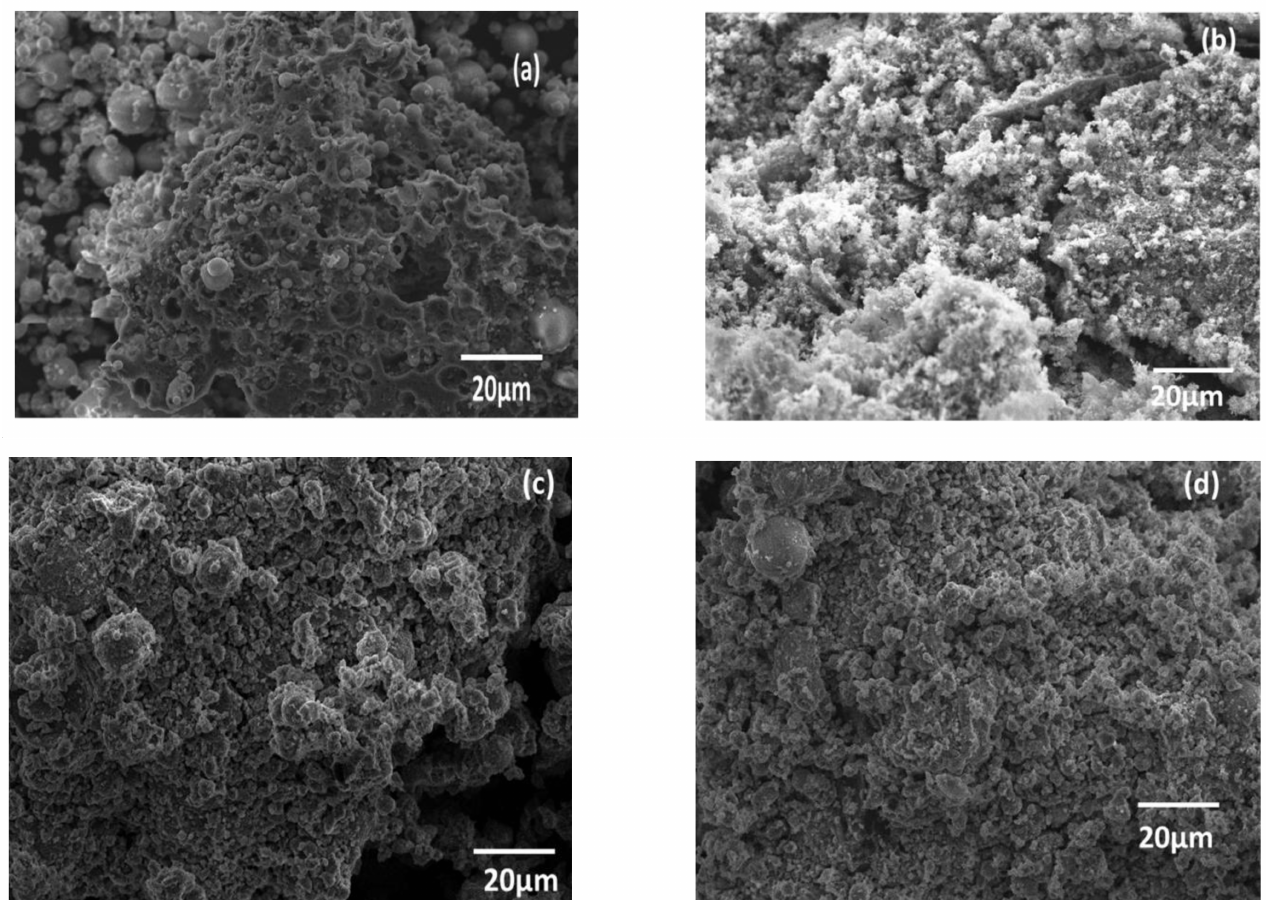
Figure 3. SEM images: ( a ) Fly ash; ( b ) TiO 2 nanoparticles; ( c ) Geopolymer; ( d ) Geopolymer- NanoTiO 2